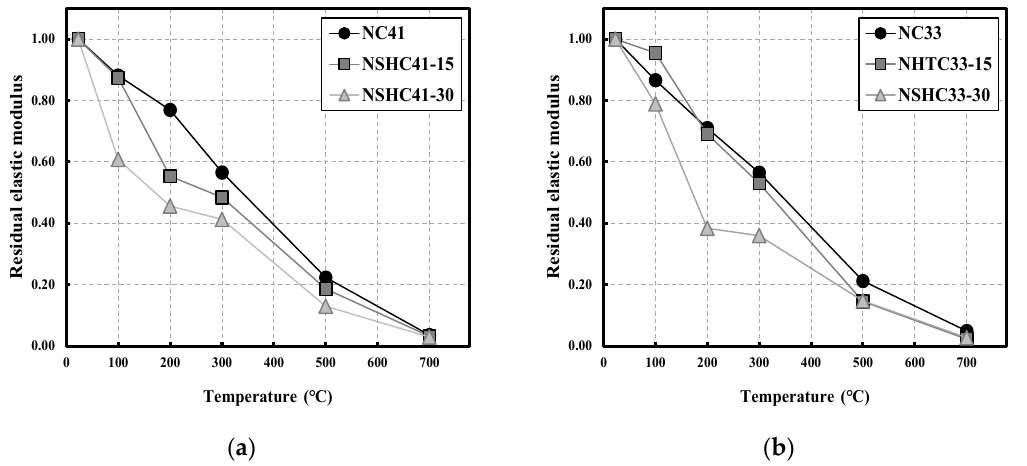
Figure 9. Residual elastic modulus of NC and NSHC after high-temperature exposure: ( a ) W/B 41; ( b ) W/B 33.